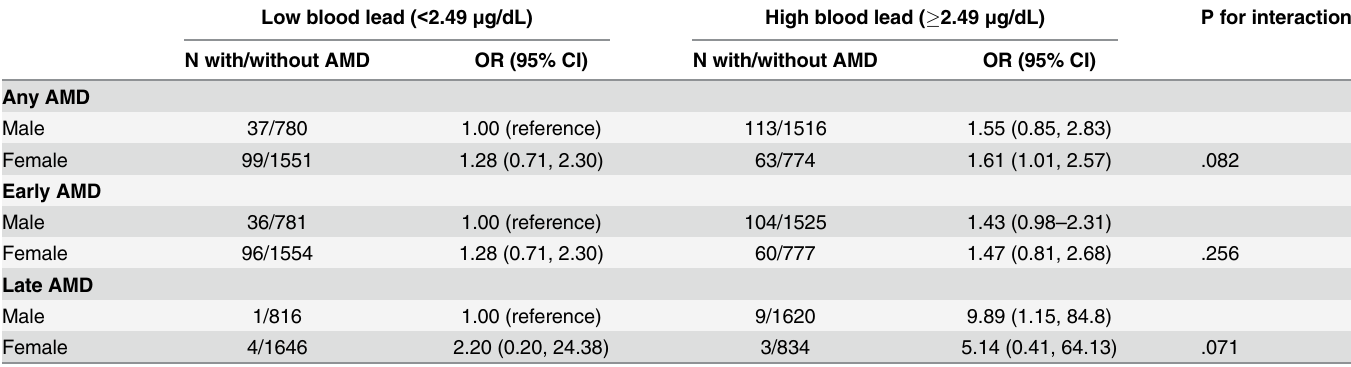
Table 6. Effect modification between blood lead levels and age-related macular degeneration (AMD) by gender, age group among representative Korean adults aged 40 years or older included in the study. Association was expressed as odds ratio (OR) with 95% confidence intervals. Low blood lead ( < 2.49 μ g/dL) N with/without